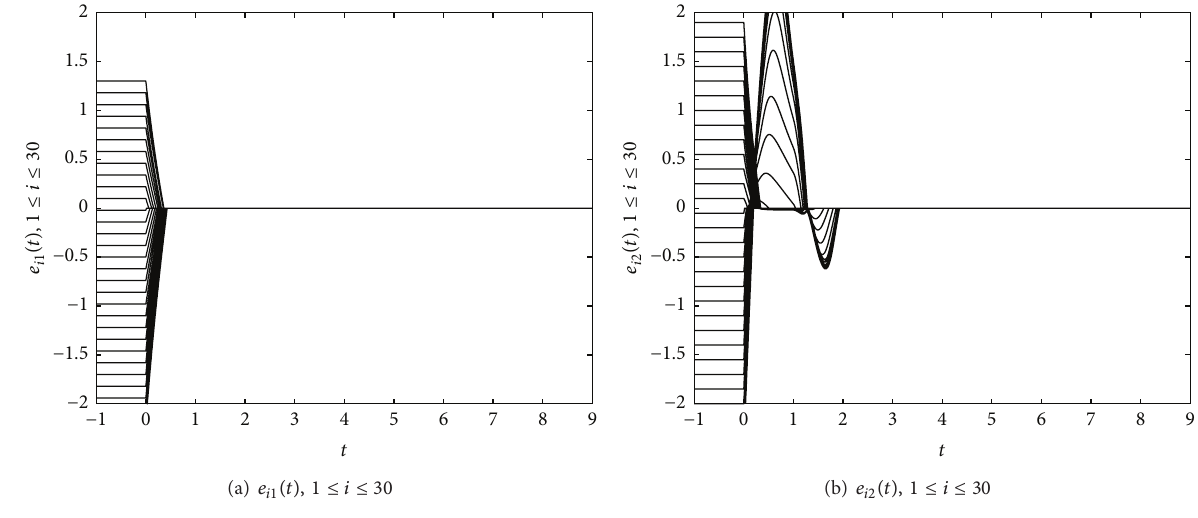
Figure 9: Synchronization errors between (39) and (36) with adaptive controllers (9).